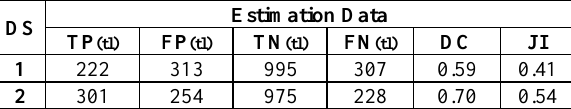
Table 1. Results of the estimations made using the models trained with both non-augmented/unbalanced (DS 1) and augmented/balanced datasets (DS 2). TP , FP , TN and FN correspond to True positive , False Postive , True Negative and False Negative , respectively; all of them are measured in numbers of pixels. DC stands for Dice Coefficient , while JI represents Jaccard Index , both presented as percentual quantities. The tl designation should be read as tiles number . DS is a short form of